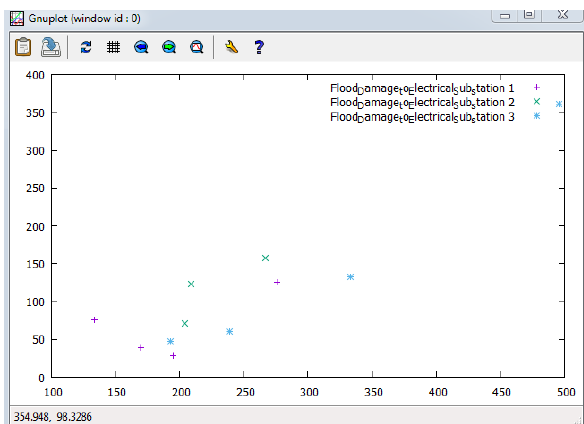
Figure 6. Disruption to Electric Supply CI Due to Flood.